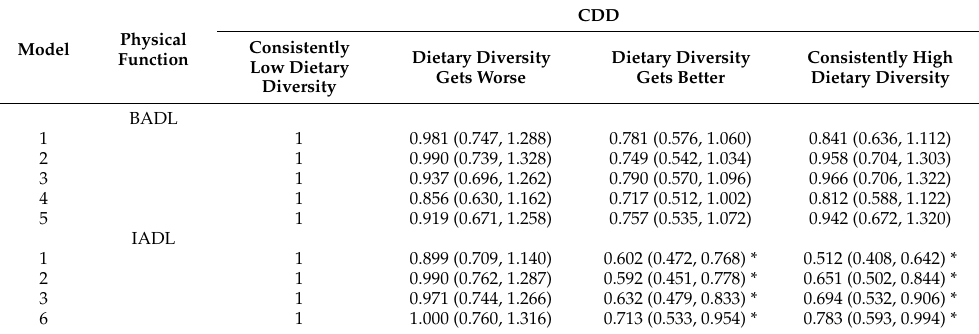
Table 4. Logistic regression analysis between change of dietary diversity and physical function ( n = 2282). CDD Consistently Model Physical Dietary Diversity Dietary Diversity Function Low Dietary Gets Worse Gets Diversity